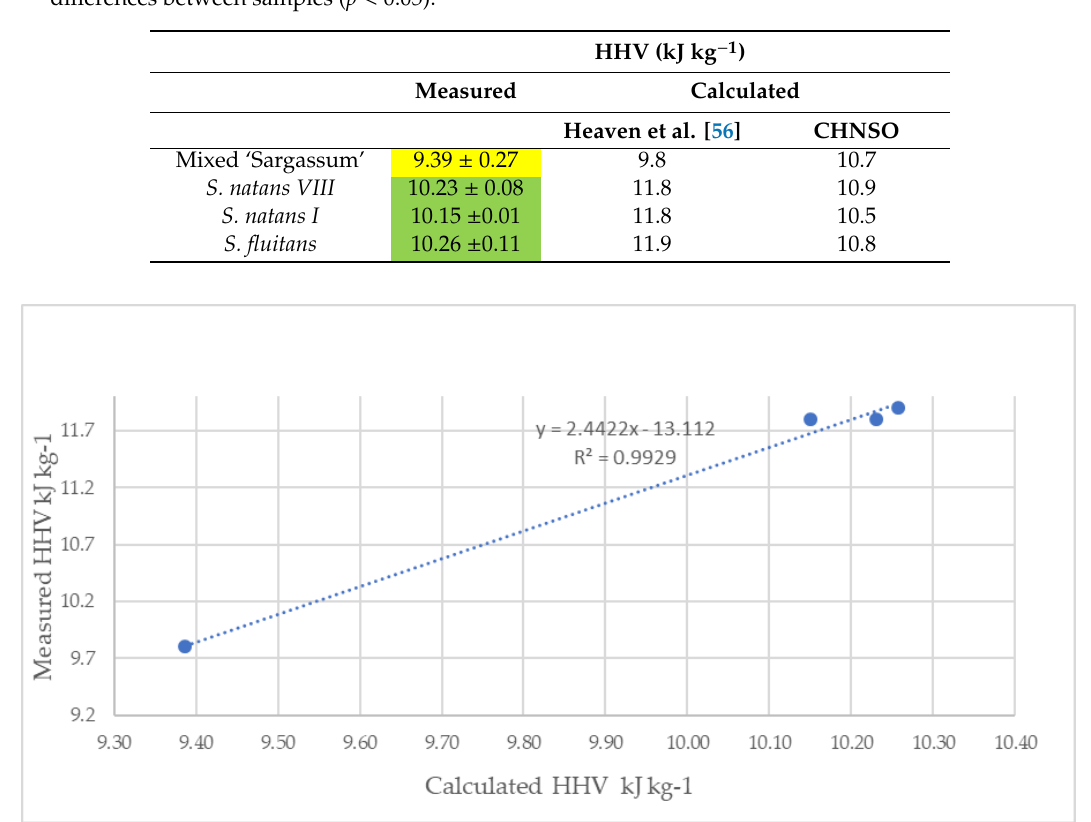
Figure 3. Calculated HHV based on the protein, lipid and carbohydrate (including fibre) content [56] and average measured data.